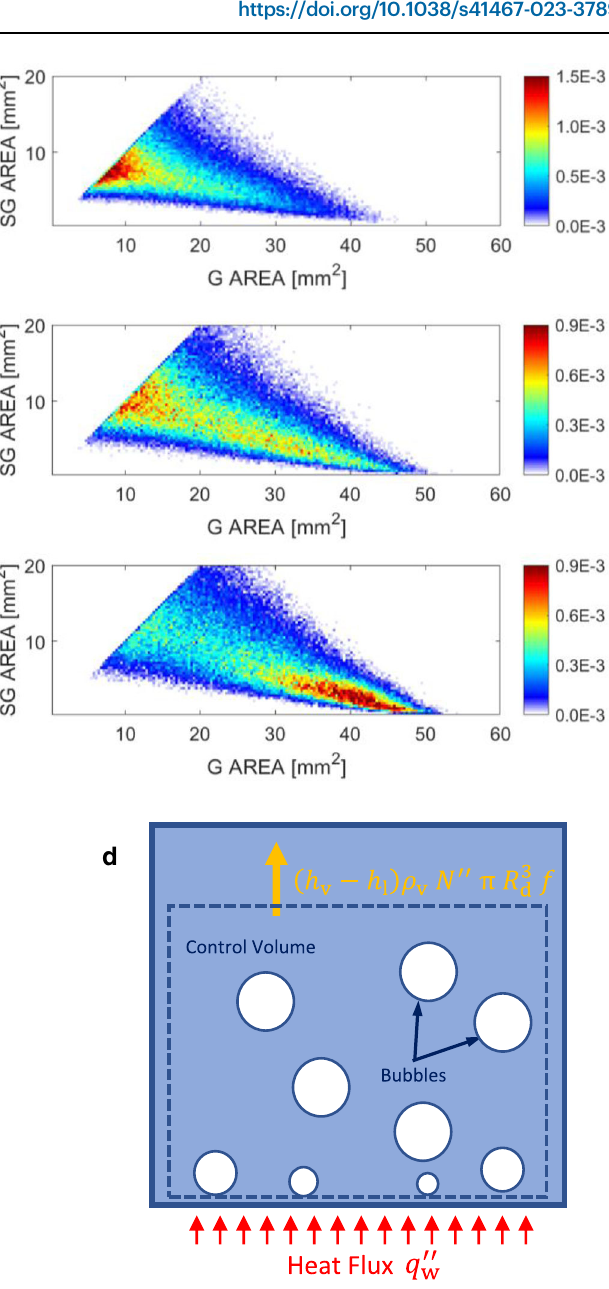
(bottom) conditions. c Sensitivityof thecriticaltriplet to the nondimensionalarea. Criticaltriplet (dashed) line, ± σ (lightblue), and ±2 σ (teal)vs. nondimensionalarea A h = π R 2 . d Control volume for the hydrodynamic scaling analysis. The volume exchanges energy at the bottom surface (with a heat fl ux q 00 w ) and at the top boundary, by releasing bubbles and receiving saturated